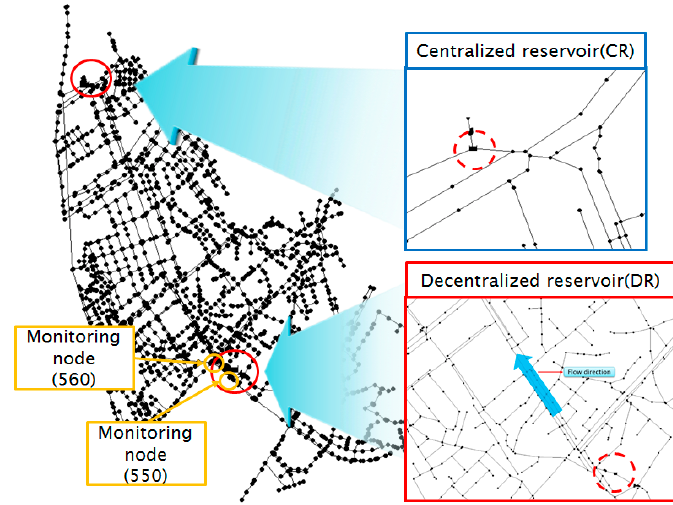
Figure 11. Urban drainage systems in the target area.